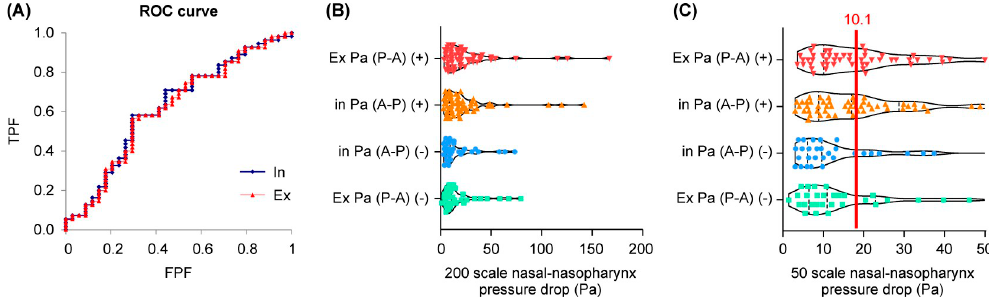
Fig 1. Receiver operating characteristic (ROC) curve and Nasal-nasopharyngeal pressure drop at maximum flow (nnPD). a. Receiver operated characteristic (ROC) curve in patients with mouth breathing and nasal breathing in exhalation and inspiration. The cut-off point was taken as the point closest to the upper left corner of the ROC curve. b. c. Nasal- nasopharynx pressure drop at maximum flow (nnPD) values during inhalation (In) and exhalation (Ex). b. nnPD values for participants with (+) and without (-) mouth breathing plotted on a scale from 0–200 Pa. c. nnPD values for participants with (+) and without (-) mouth breathing plotted on a scale from 0–50 Pa. The cut-off point calculated from the ROC curve was indicated by the red line.